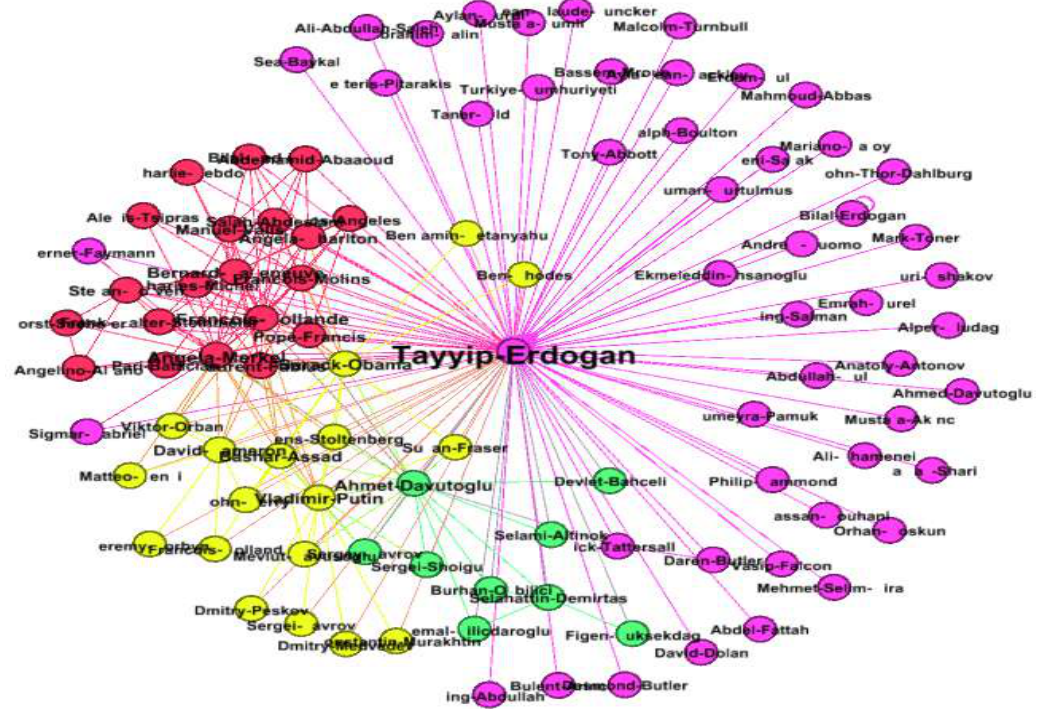
Figure 14: Modularity 2015 (Source: Authors ‟ depiction)